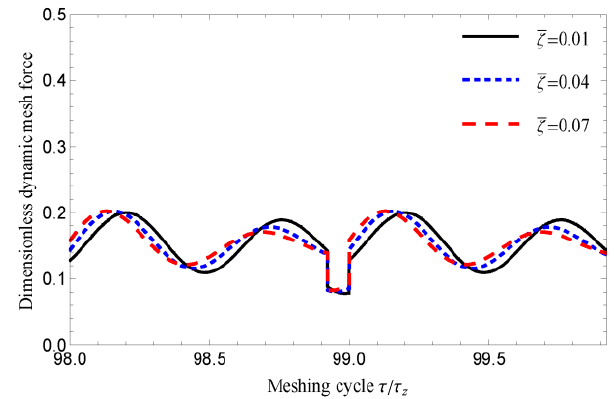
Figure 26. The dynamics characteristics with differen t 𝜁̅ : ( a ) time history diagram; ( b ) FFT spec- trogram.